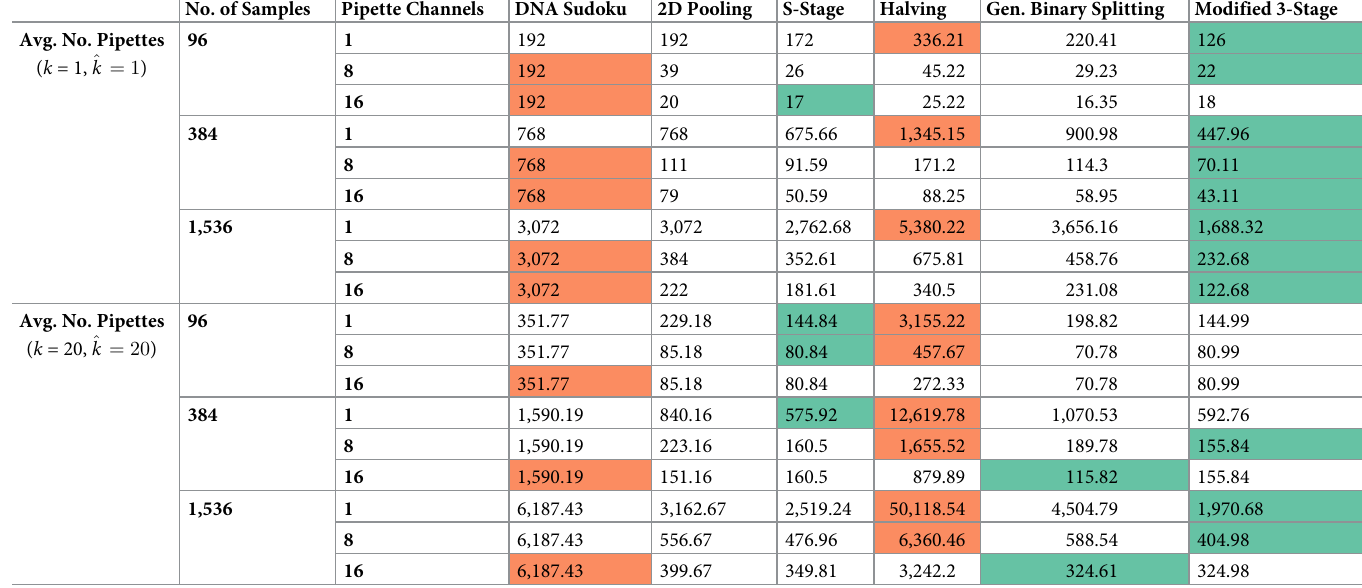
Table 5. Average number of pipettings using 1-, 8-, and 16-channel pipettes for each of the pooling methods for sample sizes N = 96, 384, and 1,536, when k = 1 and k = 20.